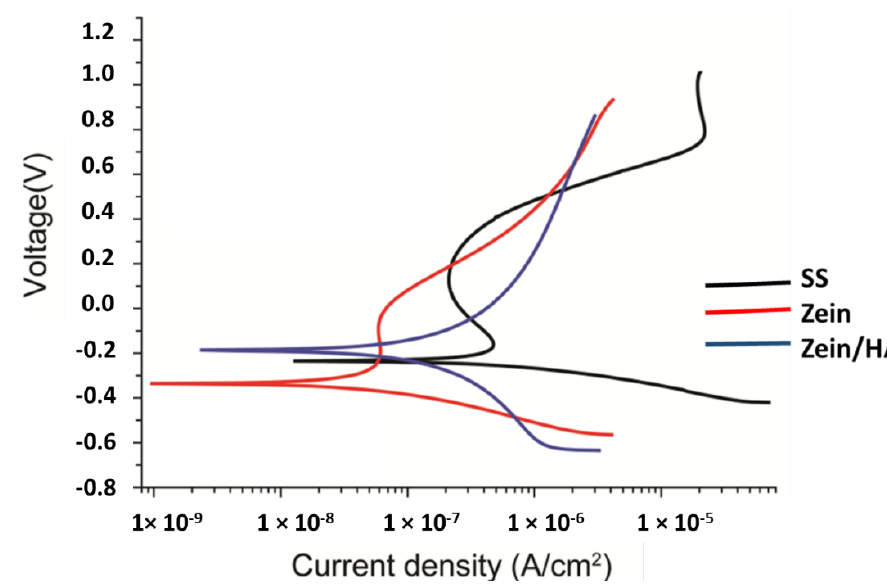
Figure 5. Polarization curves in DMEM at 37 °C for bare SS, zein and zein/HA coatings.